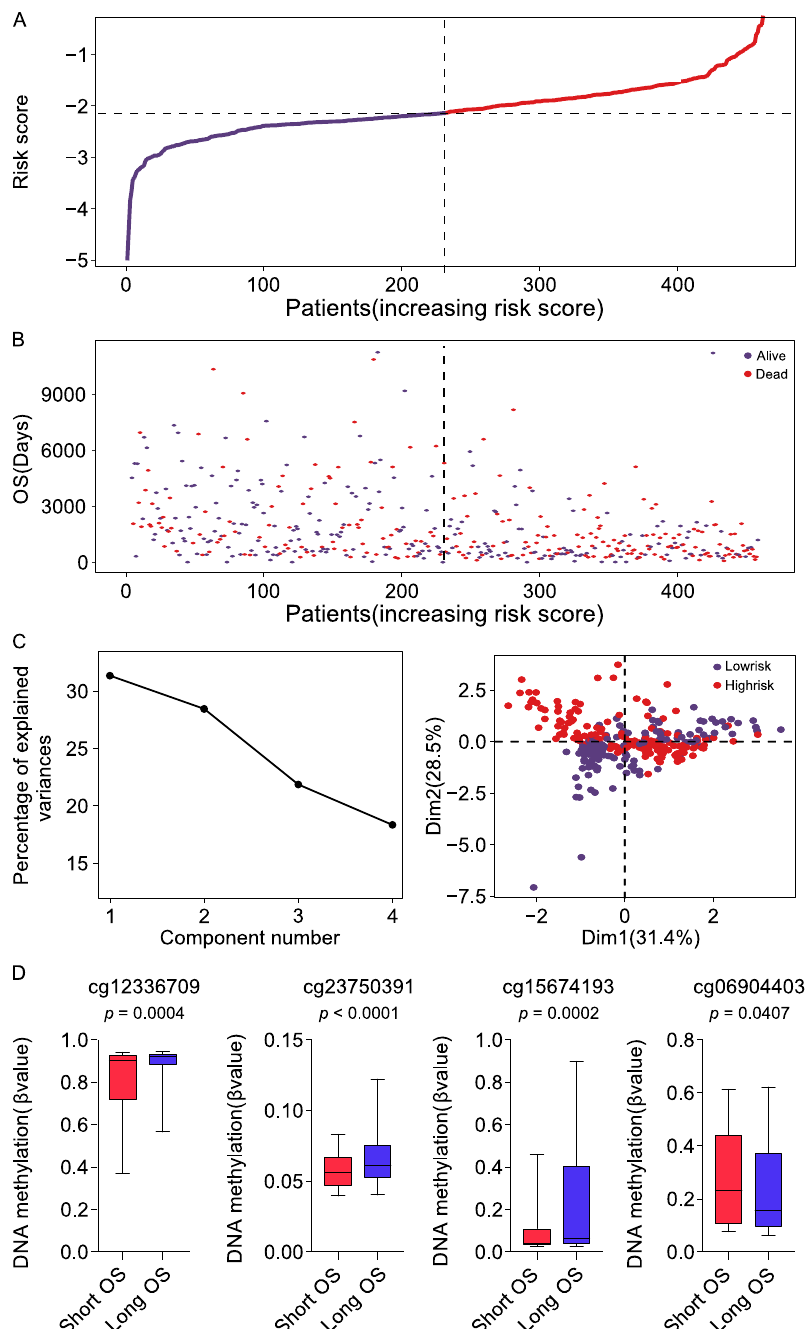
Figure 2. Correlation between prognostic signature and overall survival (OS) of patients in the TCGA cohort: ( A ) The distribution of risk score (upper) and OS (bottom). Patients were divided into high- and low-risk groups using the median score as the cut-off value. ( B ) Survival status of each patient as risk score increases. ( C ) Principal component analysis (PCA) of four DNA methylation sites. The contribution of each component was ranked according to the magnitude of the corresponding percentage of explained variants in the PCA (left). PCA plots showed the high- and low-risk groups in TCGA database (right). ( D ) DNA methylation levels of four FRG sites in patients with short (OS < 5 years) and long survival (OS > 5 years). The thick line represents the median, and the bottom and top of the box are the 25th and 75th percentiles (interquartile range), respectively, and the whiskers indicated the 5th and 95th percentiles. Differences between short and long survival groups were compared by the Mann–Whitney U test, and p values are shown below the